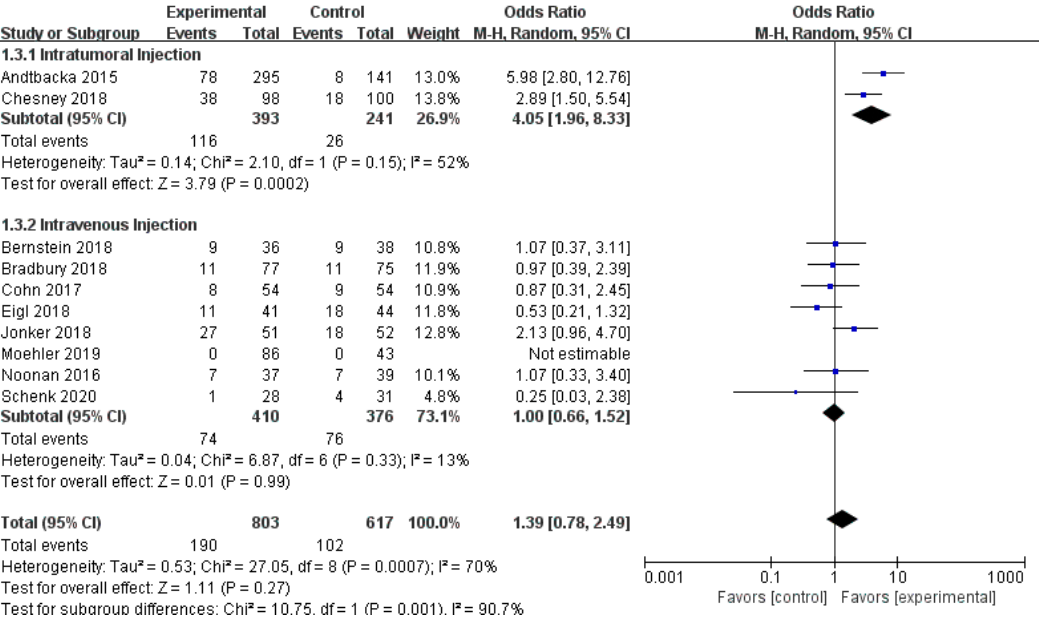
Figure 5. Forest plot of the pooled odds ratios (ORs) for objective response rate (ORR) of intratumoral and intravenous injections.